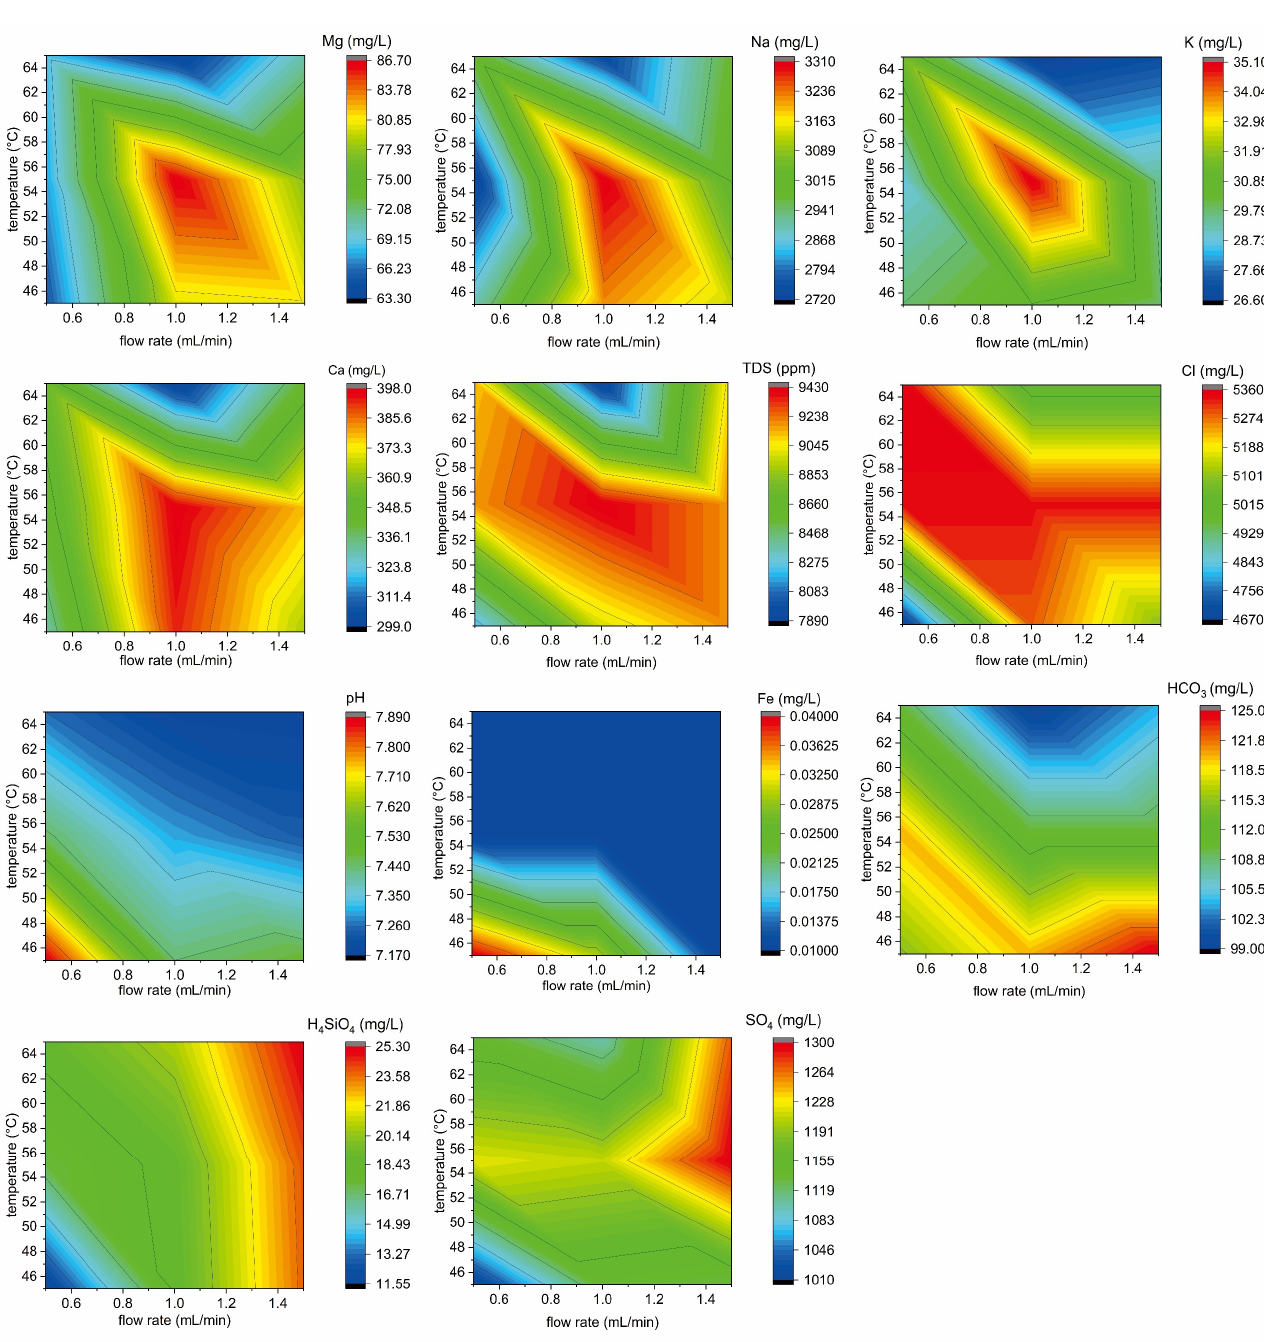
Figure 8. Contour plots of the major elemental compositions of water after the displacement exper ‐ iment under different temperature and flow conditions. ment under different temperature and flow